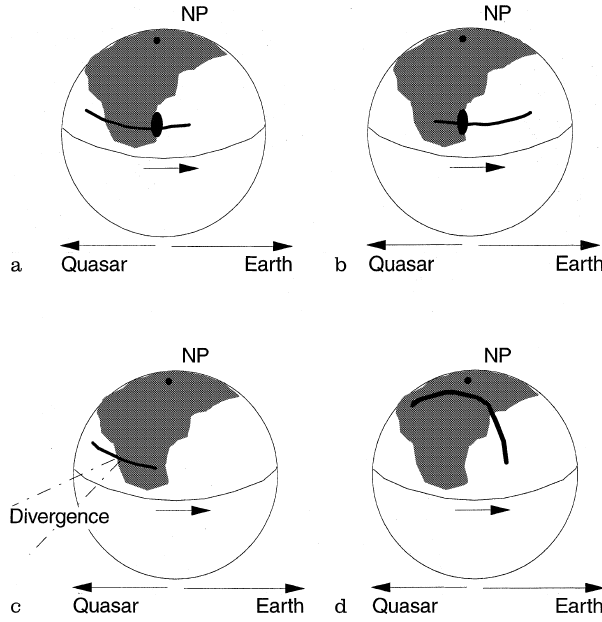
Fig. 7a–d. Schematic diagrams showing di(cid:128)erent geometries for IPS observations of fast and slow streams. The view is looking down on the Sun from the north-west. The arrow denotes the direction of rotation of the Sun, the shaded area represents a coronal hole and the heavy dark line the IPS ray-path projected down onto the disc of the Sun. Black areas represent the anticipated location in the ray-path of compression regions. In a fast flow lies at a higher Carrington longitude than slow flow, and will overtake it as it expands out from the Sun, producing a compression region. The same is true in b , but in c the fast flow lies at a lower longitude and will diverge from the slow wind. In d the fast flow lies at a higher latitude than the slow flow, so the streams flow past each other without producing a